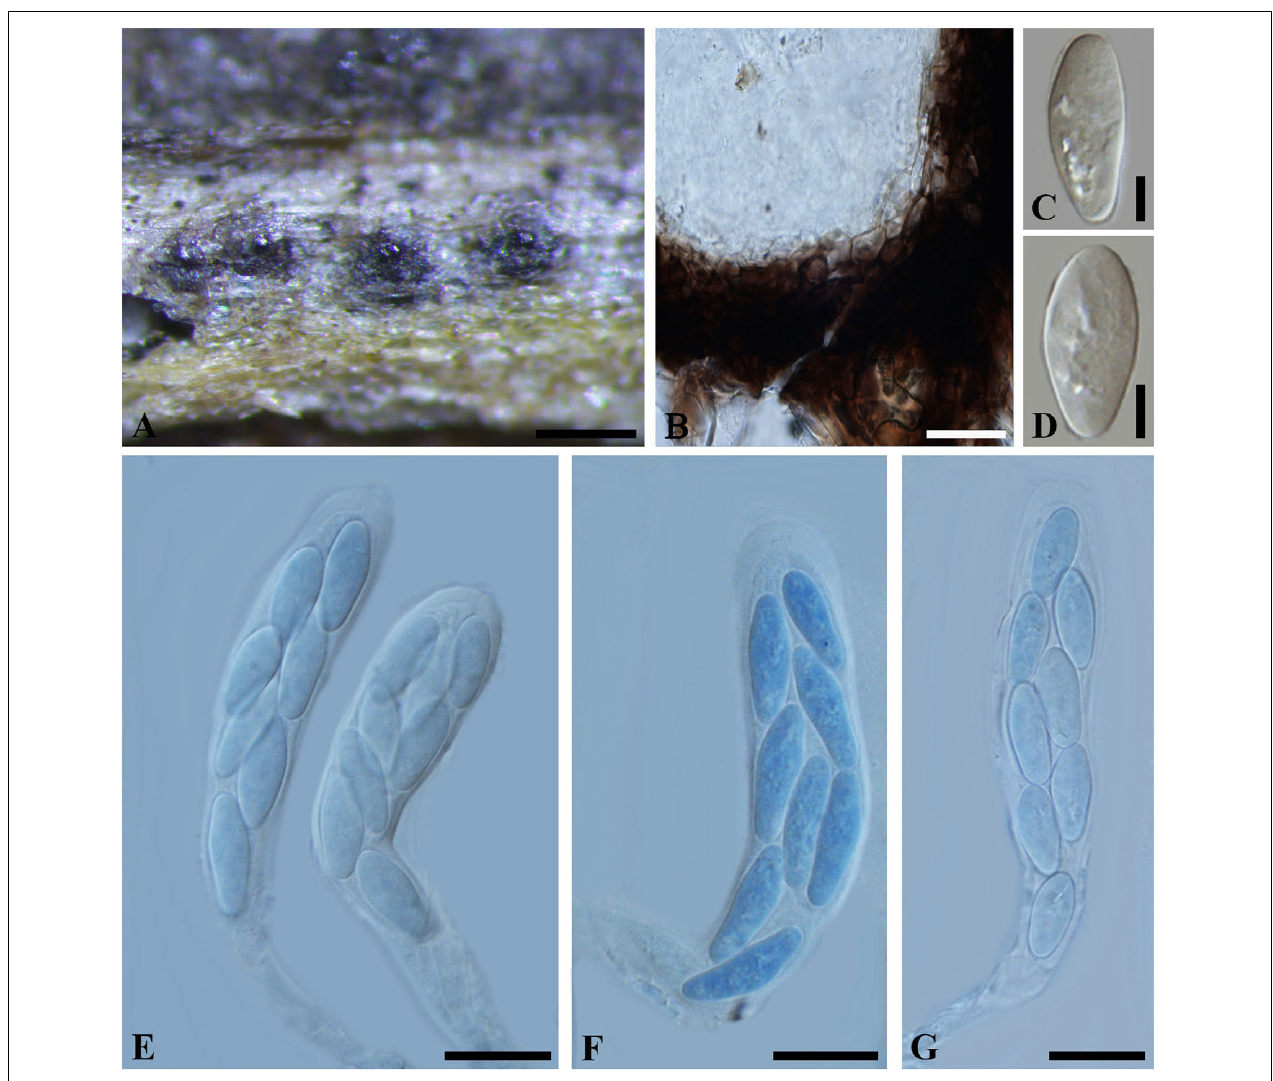
FIGURE 7 | Botryosphaeria abuensis (IMI 192142, type ). (A) Ascostroma erumpent through a twig. (B) Part of the peridium. (C,D) Released, hyaline ascospores. (E-G) Broadly clavate asci in cotton blue. Scale bars: (A) = 200 µ m, (E-G) = 20 µ m, (B-D) = 5 µ m.